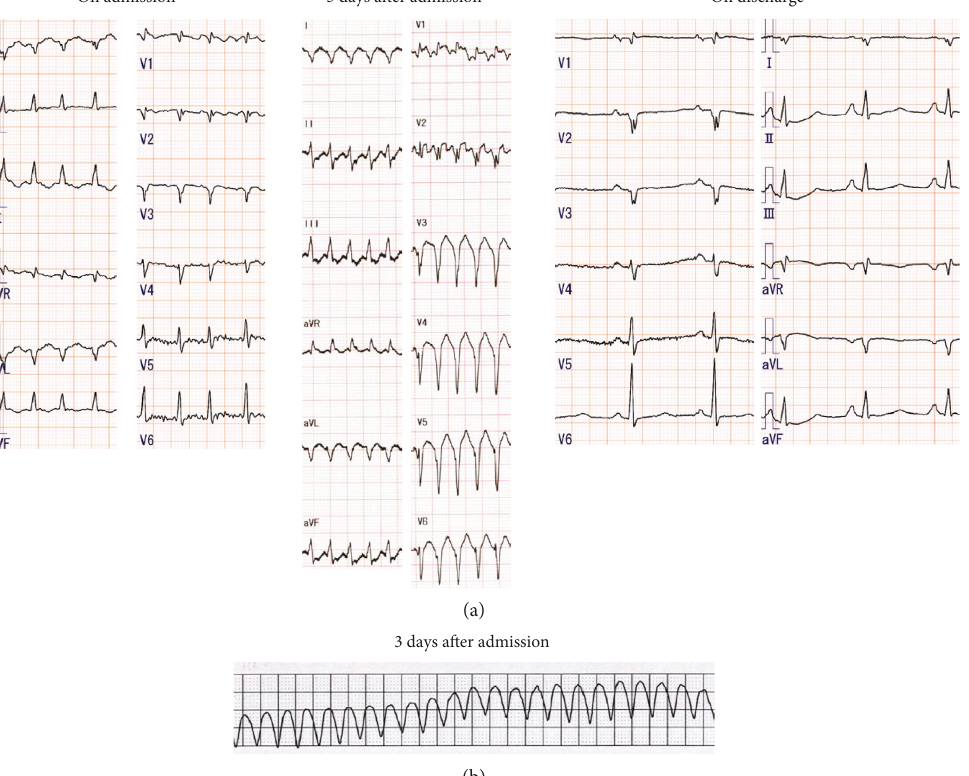
Figure 2: Electrocardiogram (ECG) findings at first admission. (a) Rapid atrial fibrillation on admission, atrial tachycardia on day 5, and normal sinus rhythm on discharge. (b) ECG monitor display showing ventricular tachycardia on day